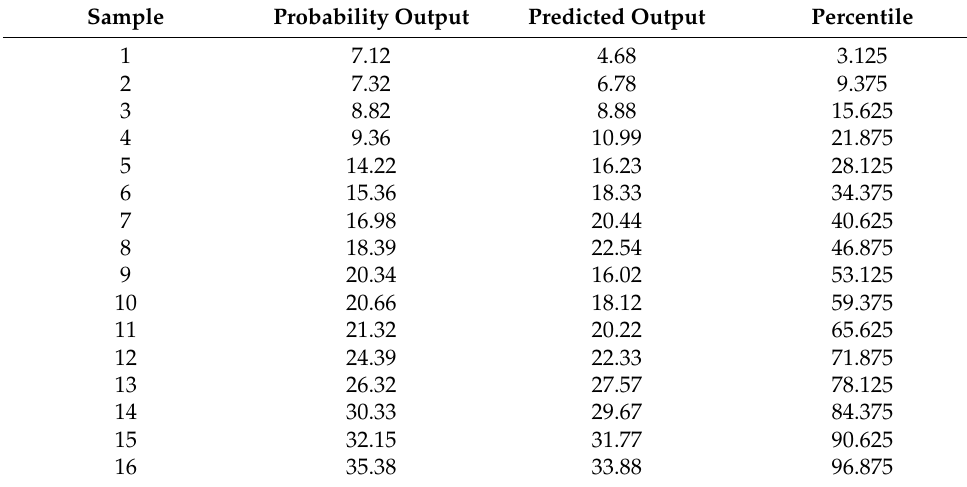
Table 11. Probability and predicted output as percentile.